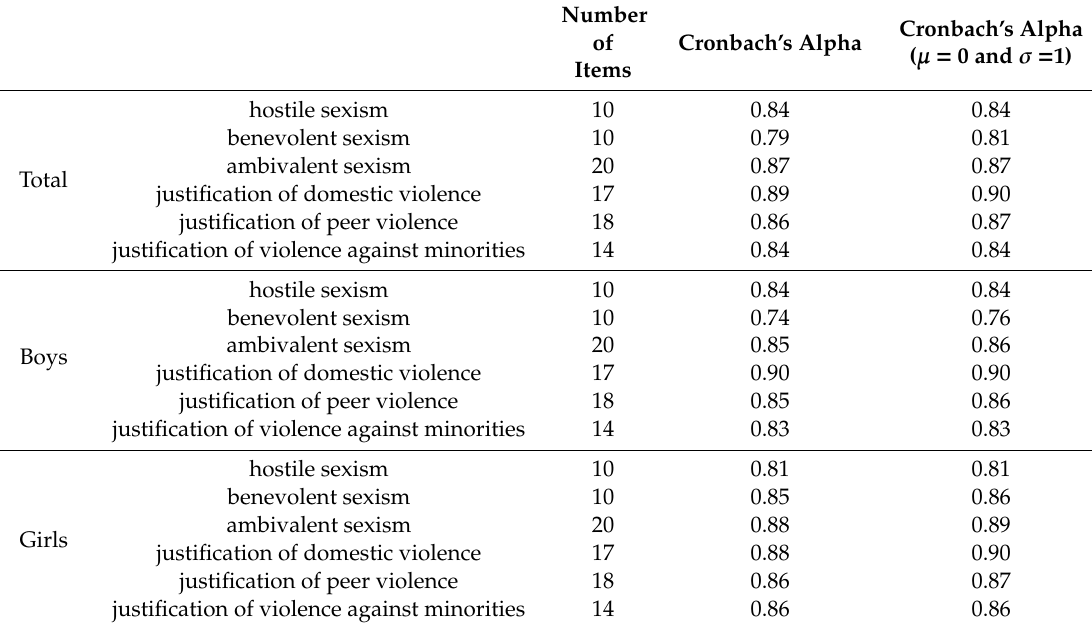
Table A2. Internal consistency—total, boys and girls.